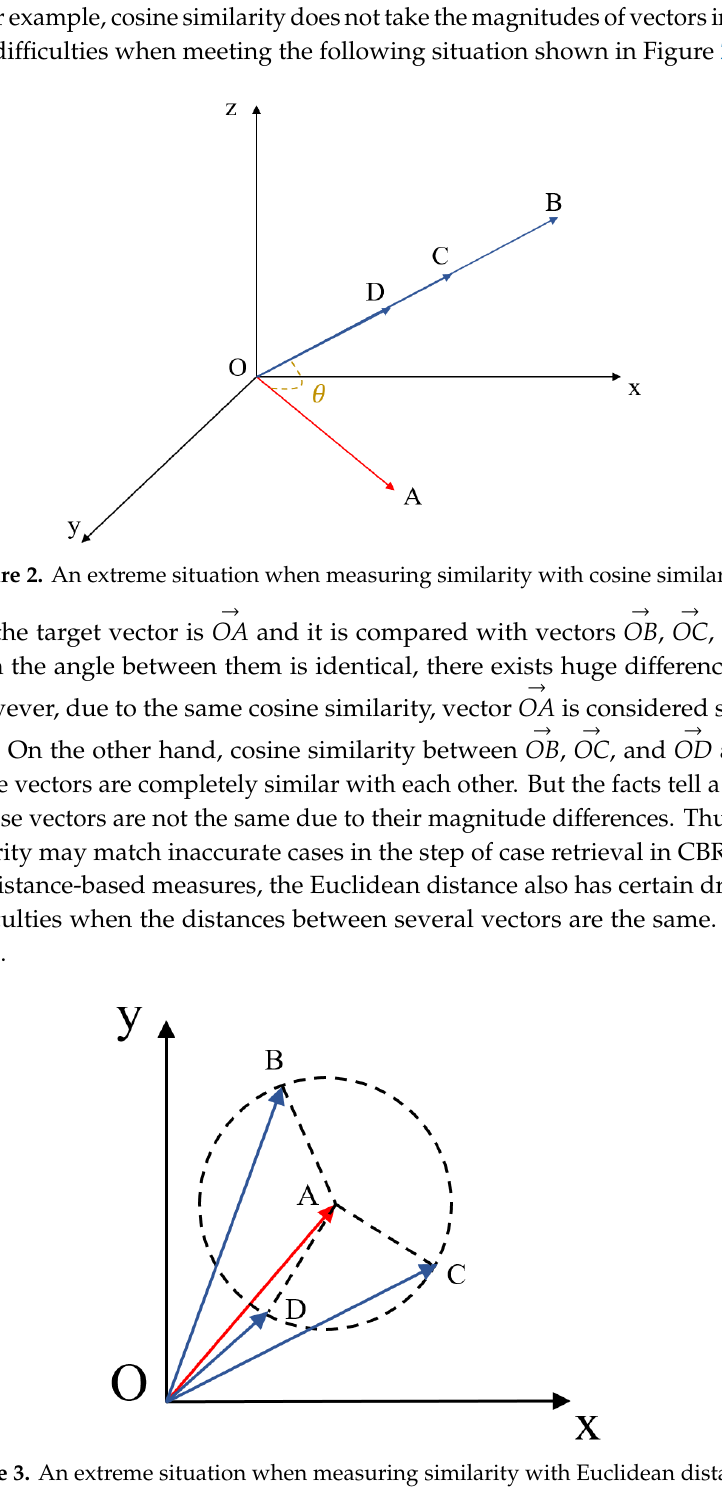
Figure 3. An extreme situation when measuring similarity with Euclidean distance.